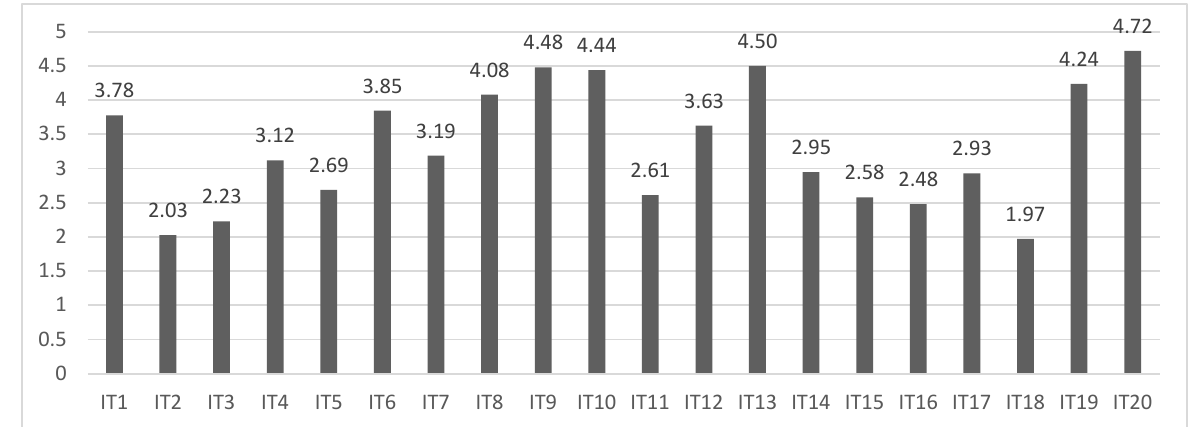
Figure 1. Mean scores for each item in the teachers’ questionnaire. The highest mean scores were for item 20 (M = 4.72, SD = 0.71), item 13 (M = 4.50, SD = 0.89), and item 9 (M = 4.48, SD = 0.82). Participating teachers highlighted the importance